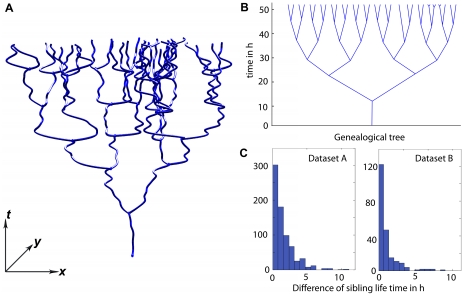
Genealogic trees and their symmetry.Reference sets A/B contain 386/85 trees with an average size of 3.5/3.8 generations, i.e. 11.3/14.2 connected paths. (A) shows a 3D-xyt-representation of the largest tree encountered; it consists of 65 paths (tree number 7 in data set B). (B) displays the same genealogy as a binary tree; the tree appears very balanced. The high symmetry is confirmed statistically by the histograms in (C), which depicts the distribution of the sibling symmetry for both data sets A and B.